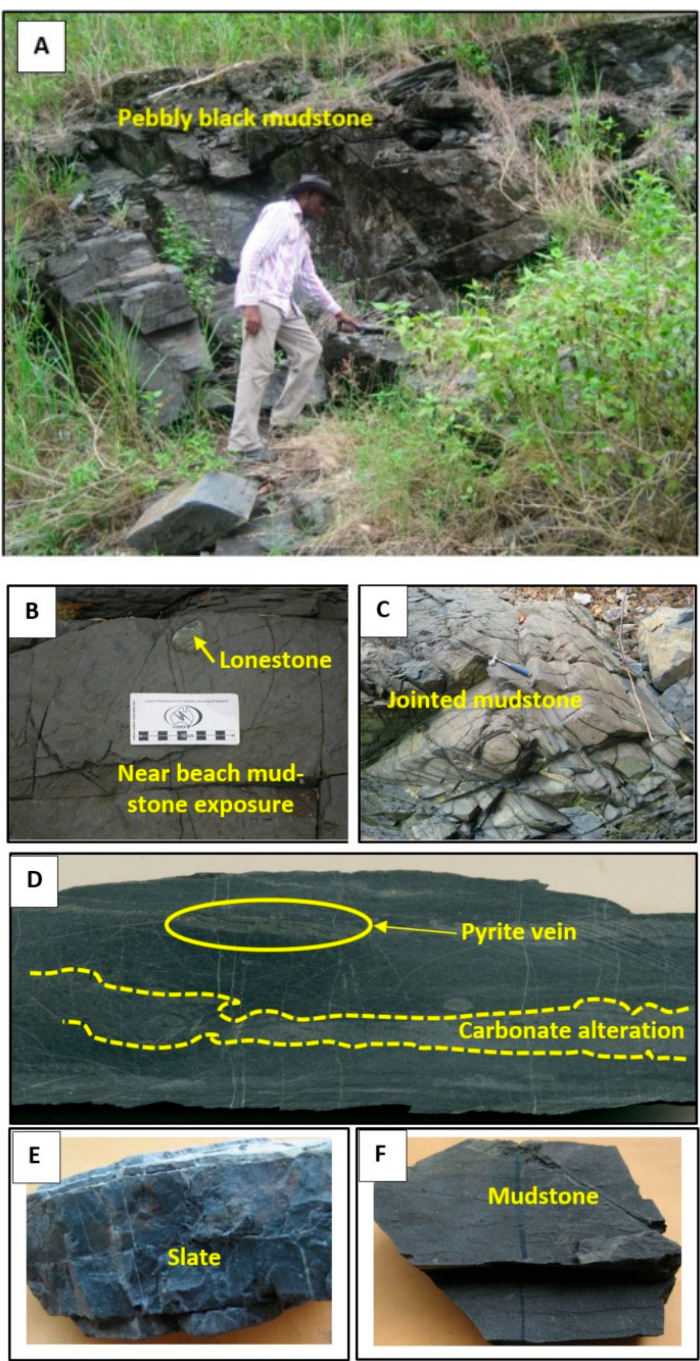
Figure 3. Photographs of outcrops and hand specimen of Singa Formation from Langkawi Islands, Malaysia. ( A ) Black mudstones exposure. ( B ) Presence of lonestones on a bedding plan of the mudstones. ( C ) Highly jointed mudstone. ( D ) Pyrite veins, carbonate alteration, and thin calcite veins cross-cutting bedding. ( E ) Slaty mudstone. ( F ) Black mudstone.